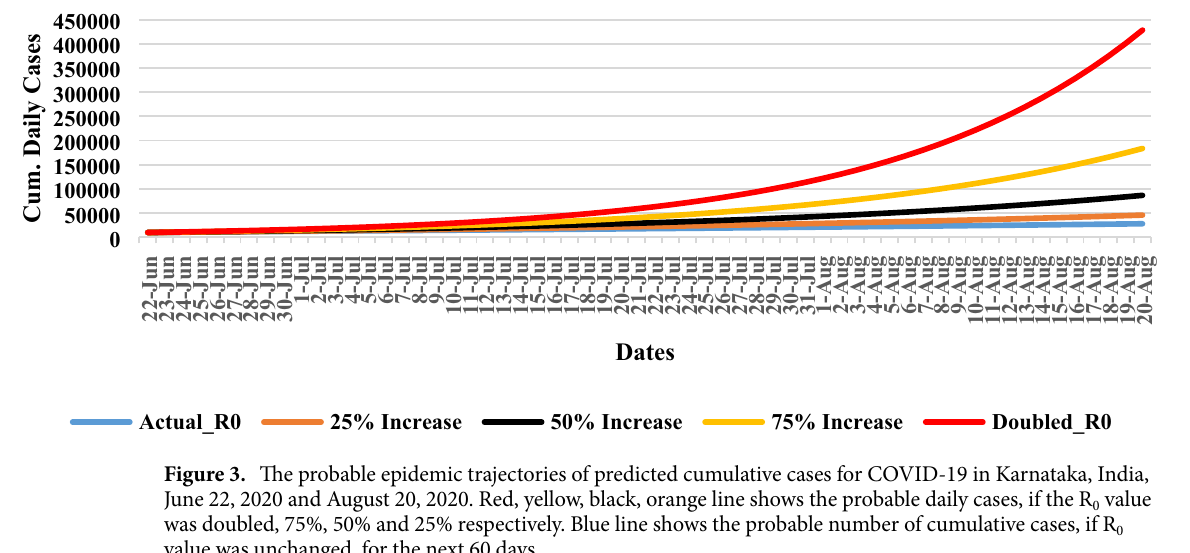
Figure 3. The probable epidemic trajectories of predicted cumulative cases for COVID-19 in Karnataka, India, June 22, 2020 and August 20, 2020. Red, yellow, black, orange line shows the probable daily cases, if the R 0 value was doubled, 75%, 50% and 25% respectively. Blue line shows the probable number of cumulative cases, if R 0 value was unchanged, for the next 60